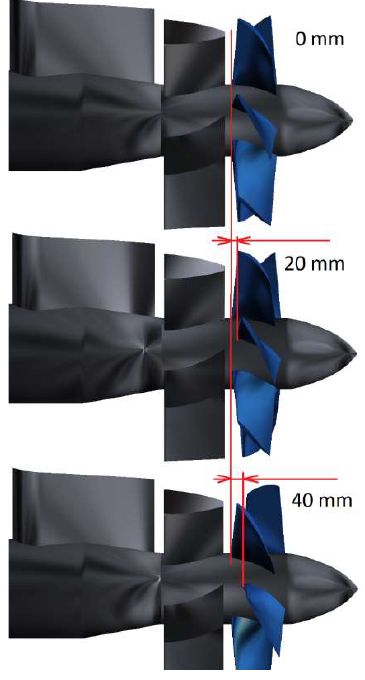
Fig. 4 The various offset of blades